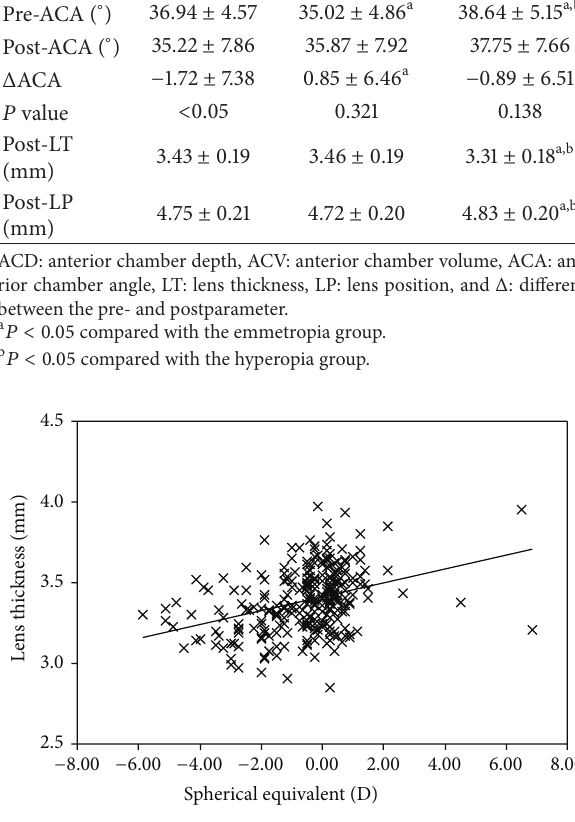
Figure 1: Association between lens thickness and refractive status in the cycloplegia.